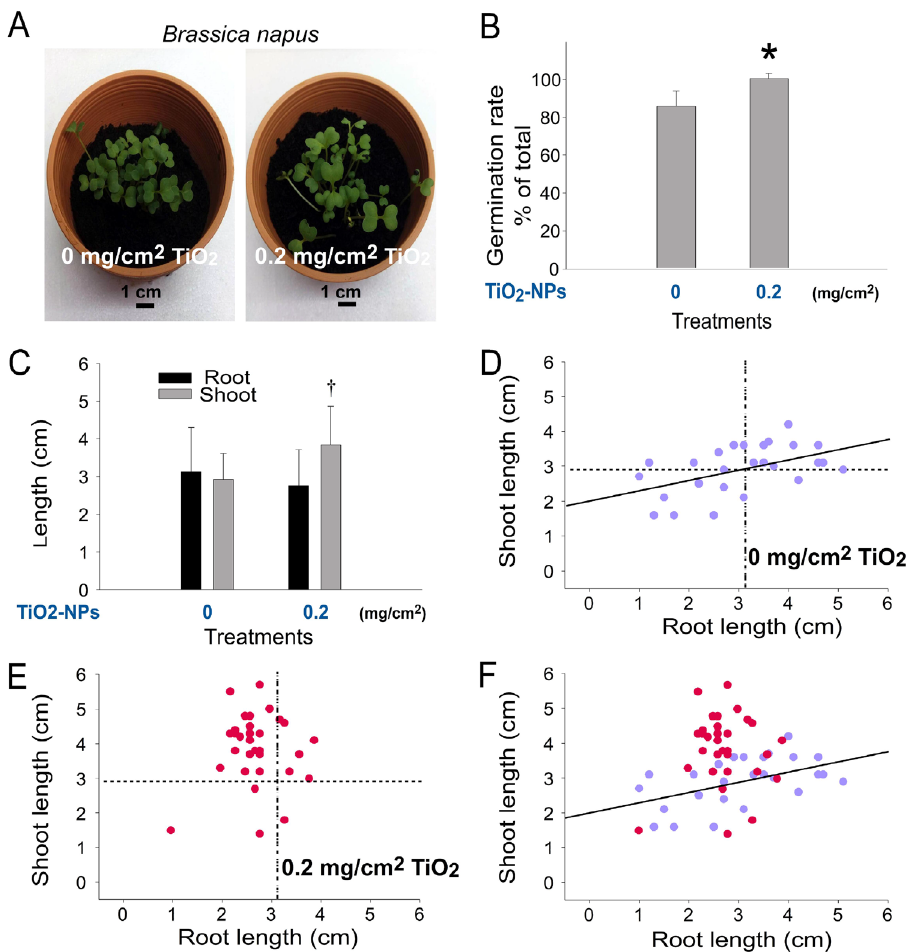
Figure 8. TiO 2 NP-mediated enhancement on the seed germination and growth of soil can also be applied to Brassica napus. Analyses of image ( A ), seed germination rate ( B ) and root and shoot length ( C ) of 1-week-old Brassica napus seedlings. Root–shoot 2D graphs of the seedlings without ( D ) and with TiO 2 NP treatments ( E ), and an overlay ( F ) are shown. The vertical and horizontal dotted lines in ( D,E ) are the mean values of root length and shoot length of the untreated control groups ( D ), respectively. * P < 0.05, † P < 0.05 vs. 0 mg/cm 2 TiO 2 untreated groups. n = 3 (3 independent experiments; each experiment with 30 seeds) ( B ). n = 90 (3 independent experiments; each experiment with 30 seeds) ( C ). n = 30 (3 independent experiments; each experiment with 10 seeds) (D-F). ( A ) Pot diameter: 10 cm; scale bar: 1